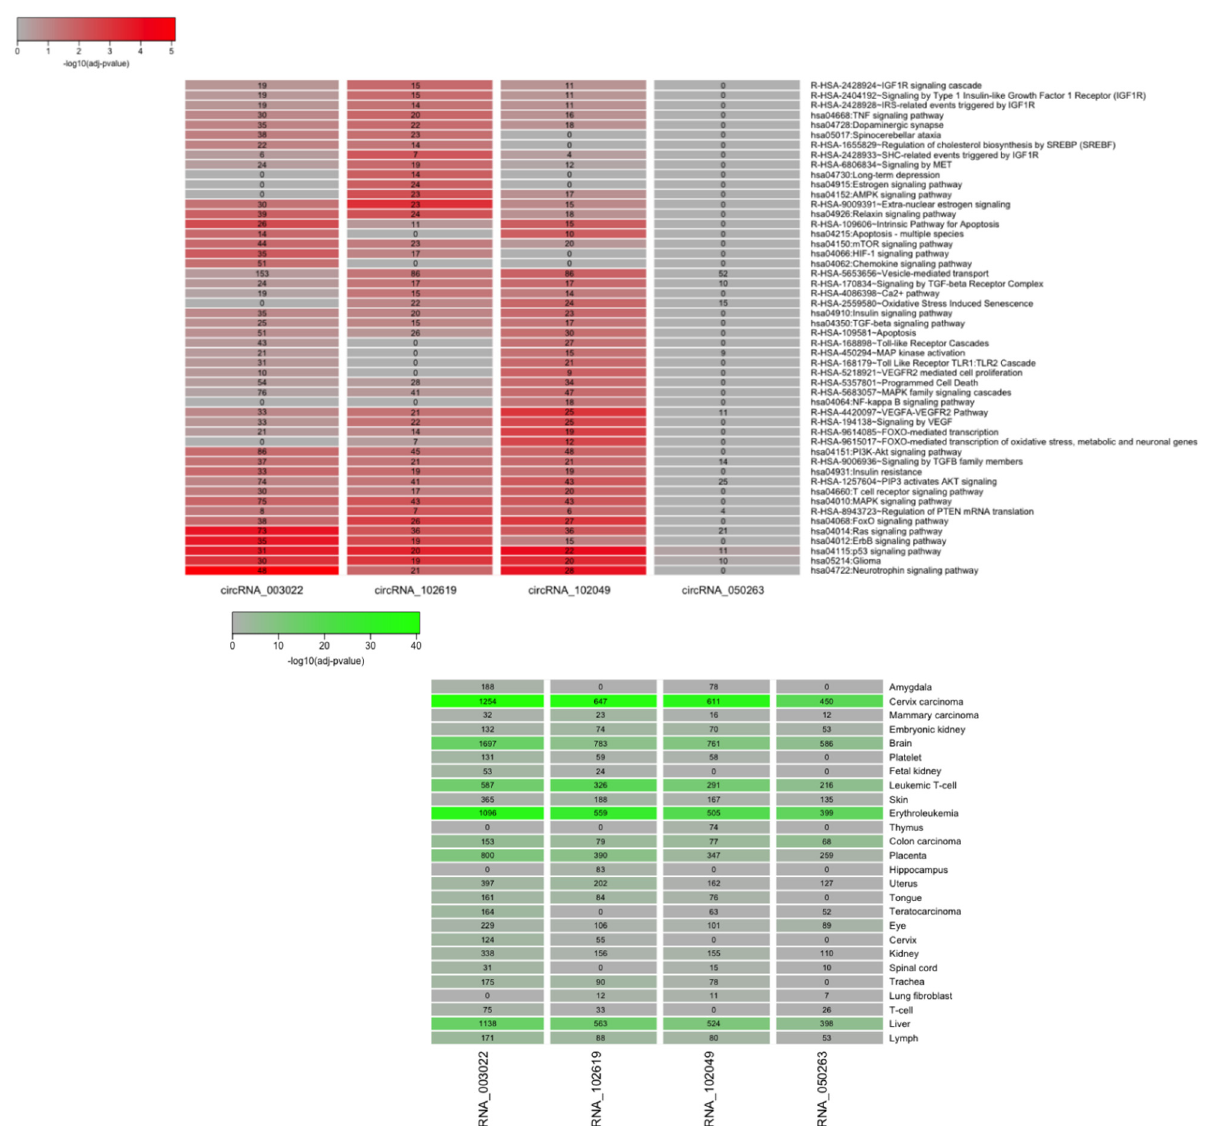
Figure 6. Comparison of Biological Processes GO terms over-represented in the groups of target proteins of each differentially expressed circRNA. All terms statistically enriched in at least one of the four groups (circRNA_003022, circRNA_102619, circRNA_102049, circRNA_050263) are reported in the heatmaps, with adjusted p -values plotted in blue-grey scale color, where blue indicates higher significant results.